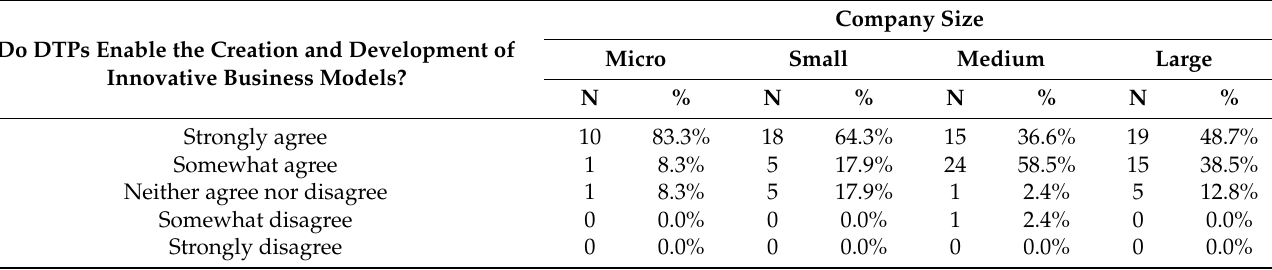
Table 3. DTPs as tools for establishing and developing innovative business models compared to company size.